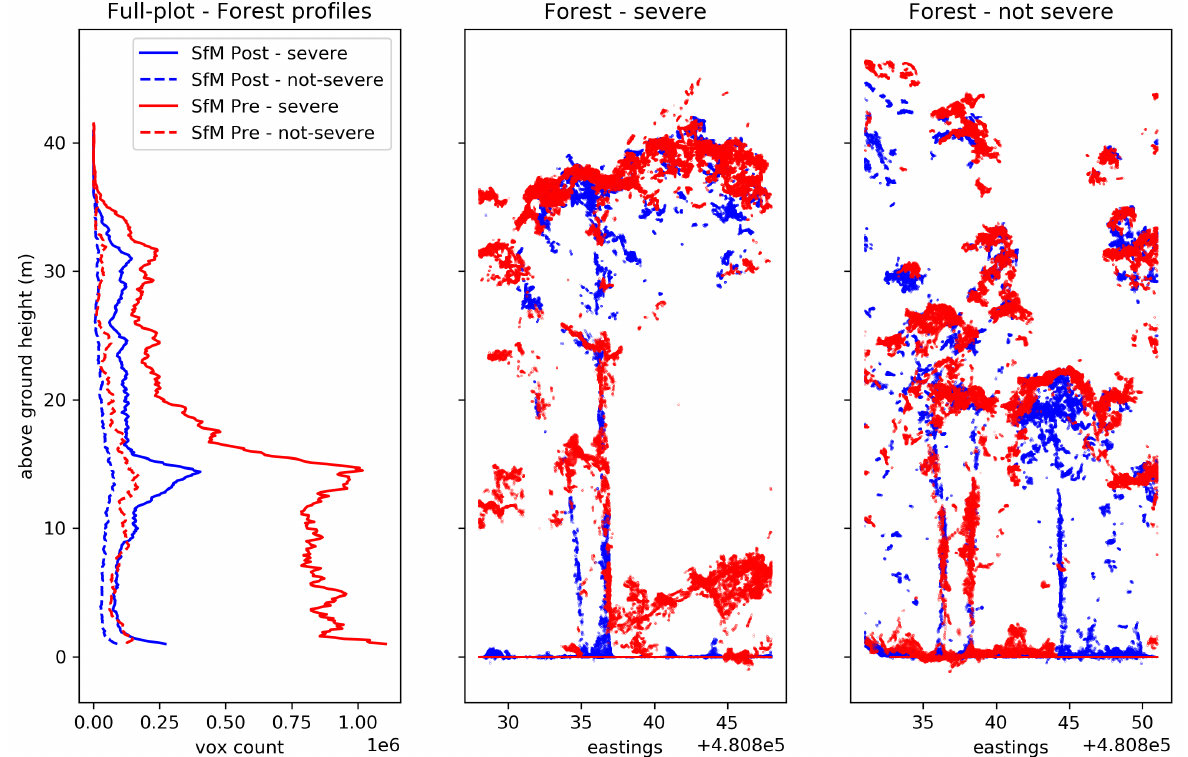
Figure 5. Differences in UAS SfM point cloud information pre- and post-fire within areas classified as